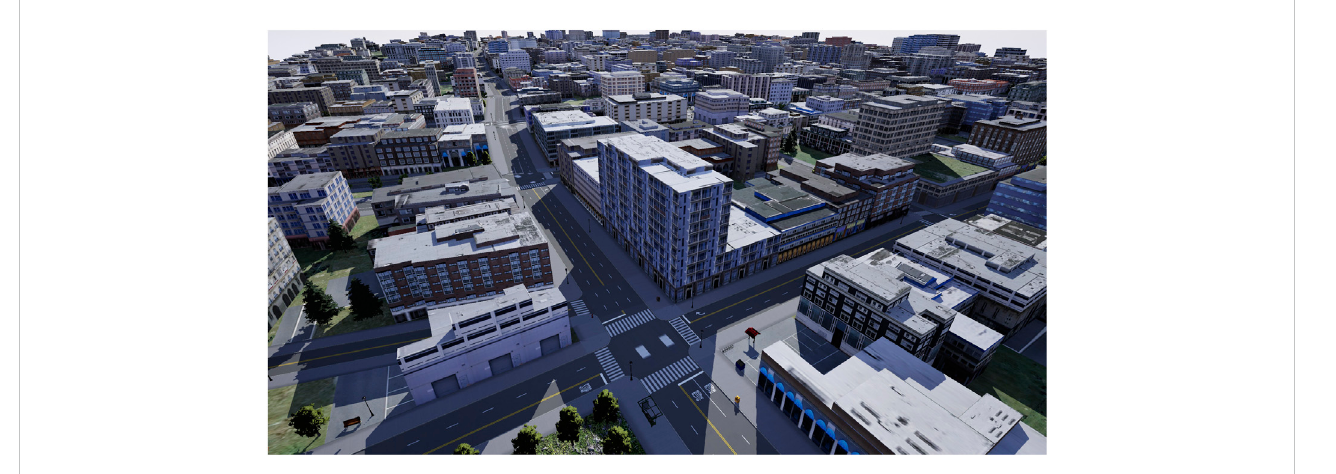
FIGURE 1 A view of the immersive virtual environment used for the